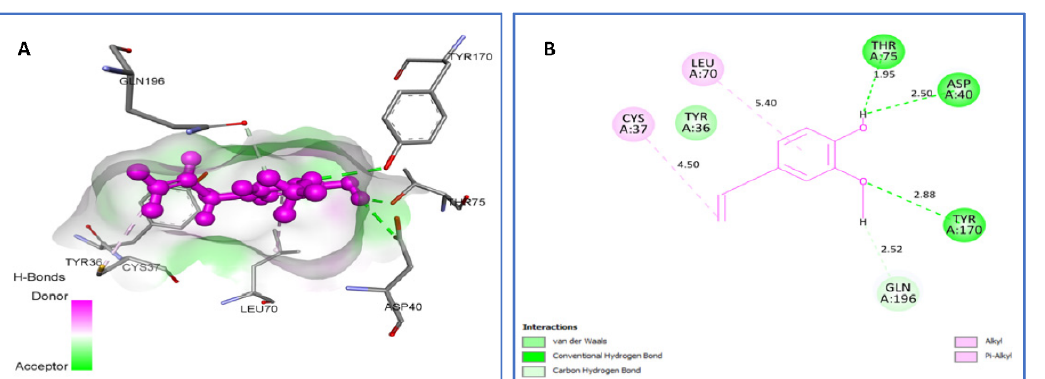
Figure 5. Two-dimensional (2D) and three-dimensional (3D) residual interactions network of euge- nol ( A , B ), trans -dihydrocarvone ( C , D ), and trans -carveol ( E , F ) with the active site of tyrosyl-tRNA synthetase (PDB Id: 1JIJ) enzyme. The best-docked natural ligands for topoisomerase II DNA gyrase were found to be cis-carveol and carvone, with the same binding energies of − 5.3 kcal/mol. Cis-Carveol forms C-H bonds with Leu1348 and Alkyl/Pi-Alkyl with Ala1351, Ile1346, Leu1168, Met1335, Leu1348, Leu1167, Ile1183, Ile1346, Val1038, and Tyr1234. However, carvone binds to 2XCT by two H bonds, Ala1337 (2.55) and Ile1346 (2.12); one C-H bond with Ile1336 and Leu1345; and Alkyl interactions with Val1038, Ala1337, Met1335, Ile1346, Leu1168, Val1339, and Leu1167 residues (Figure 6).